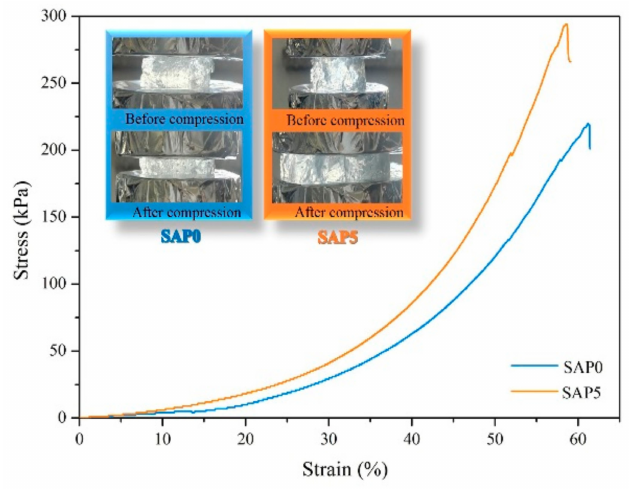
Figure 8. Stress–strain curves of SAP0 and